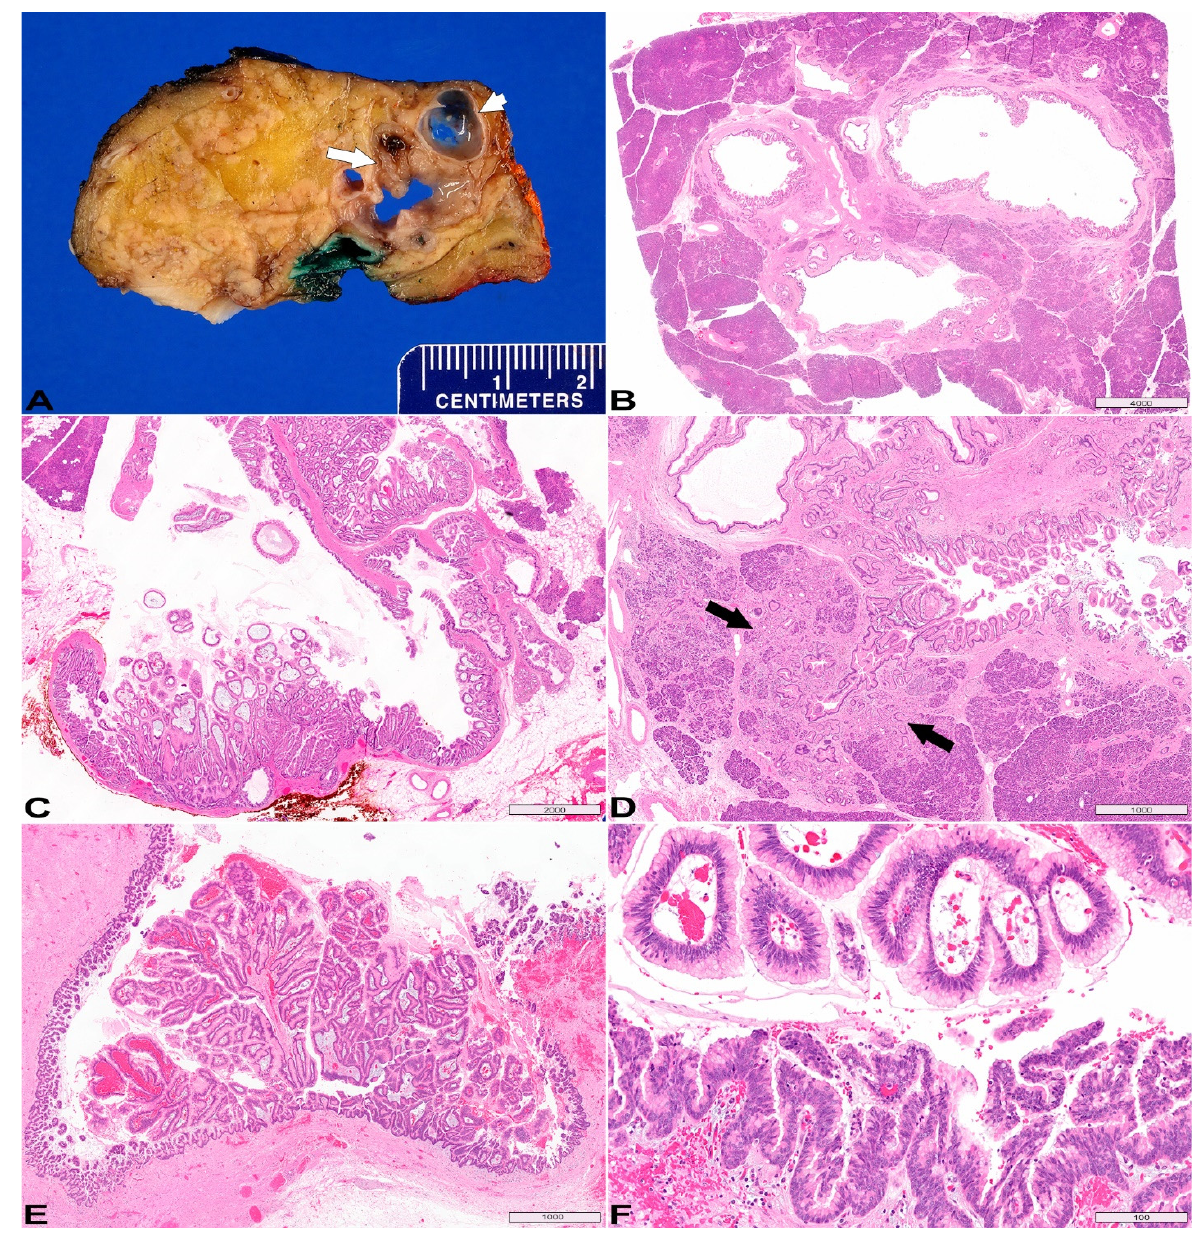
Figure 1. Intraductal papillary mucinous neoplasm (IPMN). ( A ) Gross photo of the cut surface of a resected branch-duct IPMN, characterized by multilocular, Swiss cheese appearance; short and long arrows pointing to smooth cyst lining and intraductal papillary growth respectively. ( B , C ) Variable (minimal to exuberant) intraductal, papillary epithelial proliferation. ( D ) The pancreatic parenchyma adjacent to IPMN undergoes lobular atrophy (between arrows). ( E ) A main-duct IPMN: the lumen is partially obstructed by papillary/villous neoplastic growth. ( F ) Upper half the image demonstrates low-grade dysplasia (large papillae with abundant cytoplasmic mucin and fibrovascular core, monolayer polarized nuclei), whereas the low half shows high-grade dysplasia (branching and tufting papillae, stratified nuclei with high nuclear cytoplasmic ratio). ( B – F ) Hematoxylin & Eosin (H&E) stain, original magnification 5 × , 10 × , 20 × , 20 × , 200 × respectively. Scale bars, in µ